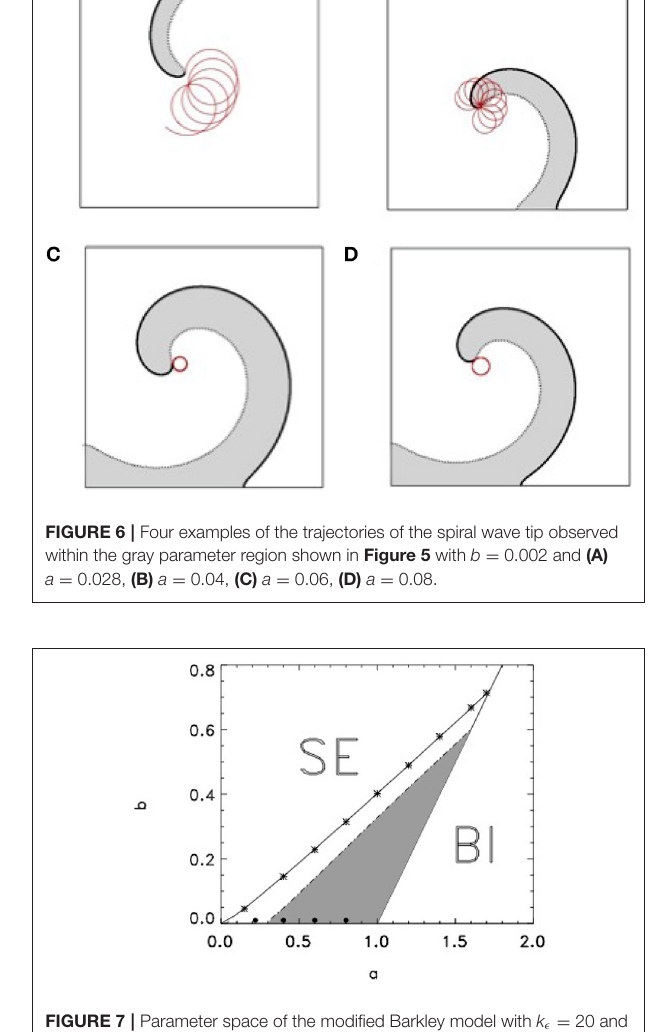
FIGURE 7 | Parameter space of the modified Barkley model with k ǫ = 20 and ǫ = 0.001. The 2D medium does not support self-sustained spiral waves within the SE domain. Within the dark gray region spiral waves are unstable. Within the white region between these two domains rigidly rotating spirals with a circular core have been observed. Black spots correspond to parameter values used in Figure 8